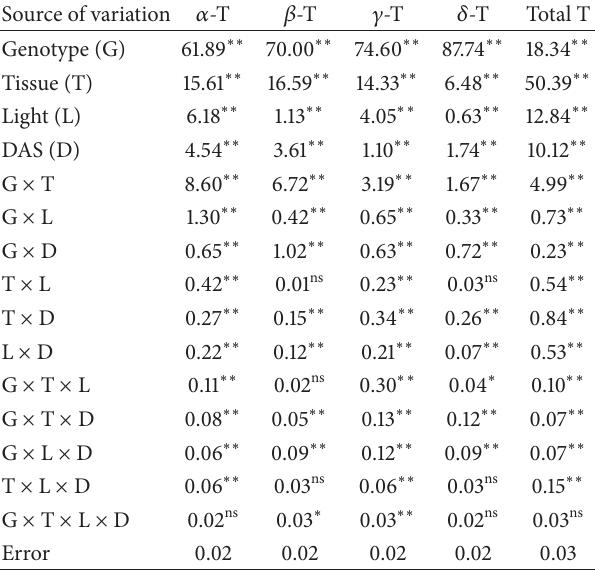
Table 2: Analysis of variance (percentage of total mean squares) for 𝛼 -, 𝛽 -, 𝛾 -, 𝛿 -, and total tocopherol (T) content (mgkg − 1 dry tissue) in cotyledons and roots of seedlings from ten sunflower lines grownunderlightanddarkconditionsfrom2to12daysaftersowing